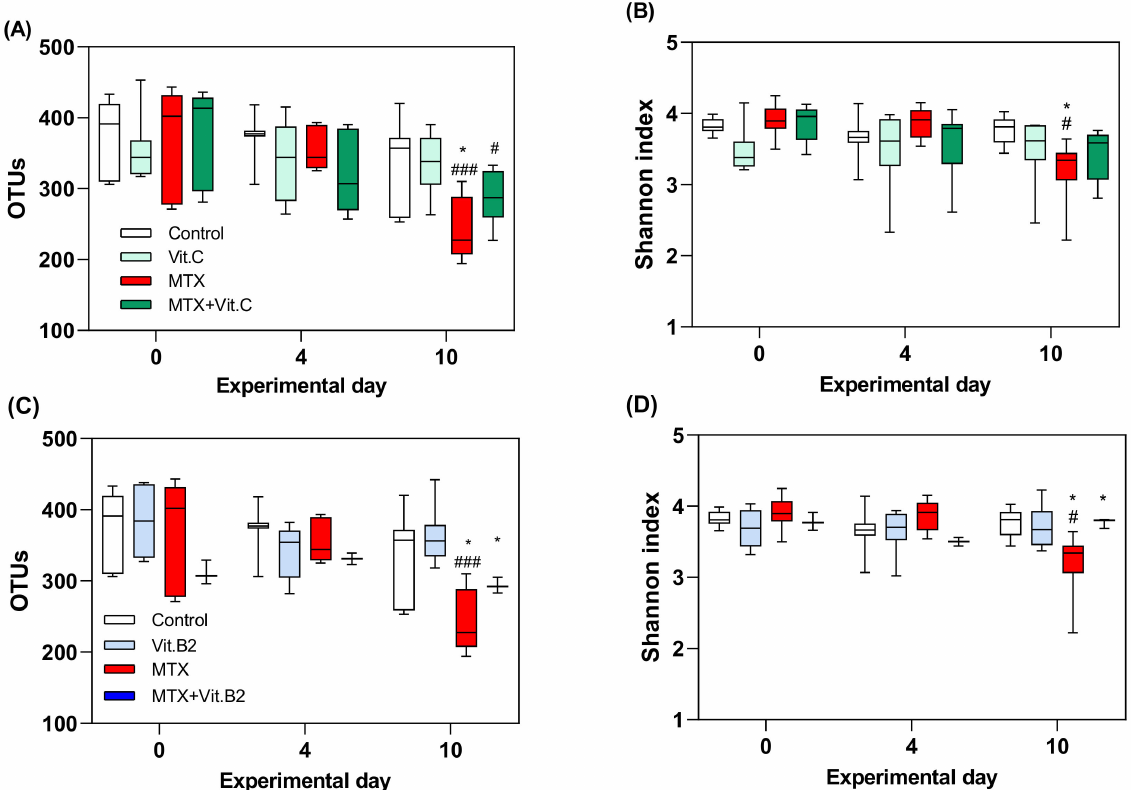
Figure 5. Dynamics of microbial composition defined as alpha-diversity (Shannon) and operational taxonomic unit (OTUs) by day of treatment. OTUs and alpha-diversity from health and MTX-treated rats supplemented with vitamin C represented by ( A , B ) and with vitamin B2 by ( C , D ). All data are presented as mean ± SEM. # ( p < 0.05) and ### ( p < 0.001) represent the significant differences within a group throughout time. * ( p < 0.05) represent the significant differences between MTX-treated and MTX and vitamin B2-treated